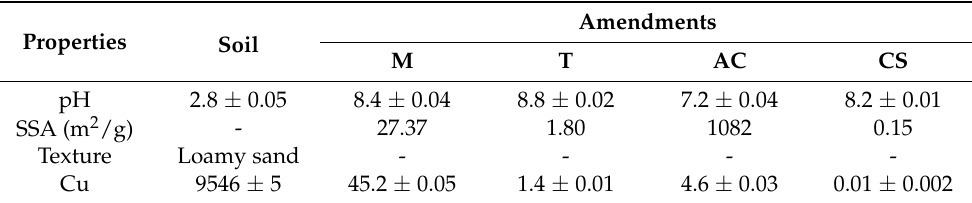
Table 1. Physical and chemical properties of the soil and amendments.